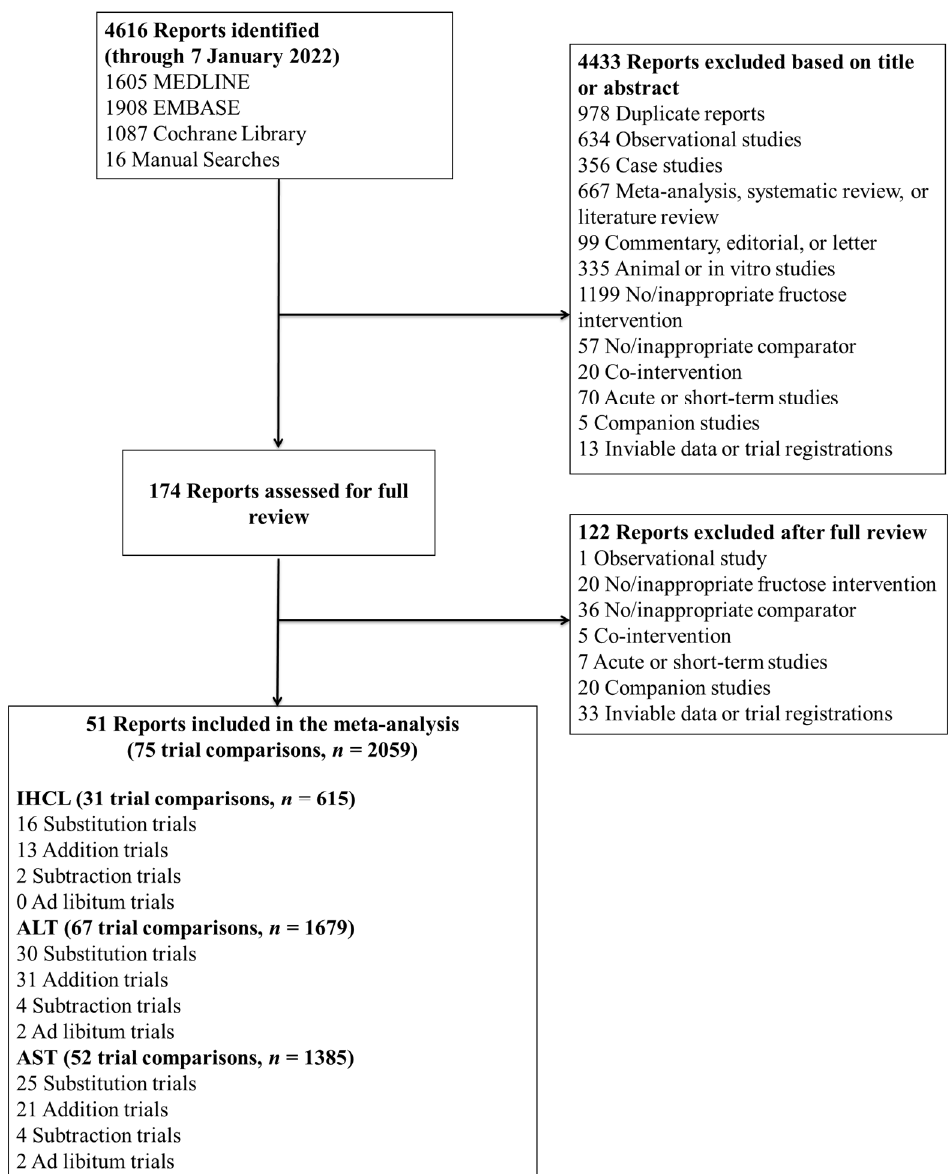
Figure 1. Flow of the literature for the effect of different food sources of fructose-containing sugars and NAFLD risk markers. ALT = alanine aminotransferase; AST = aspartate aminotransferase; IHCL = intrahepatocellular lipid.